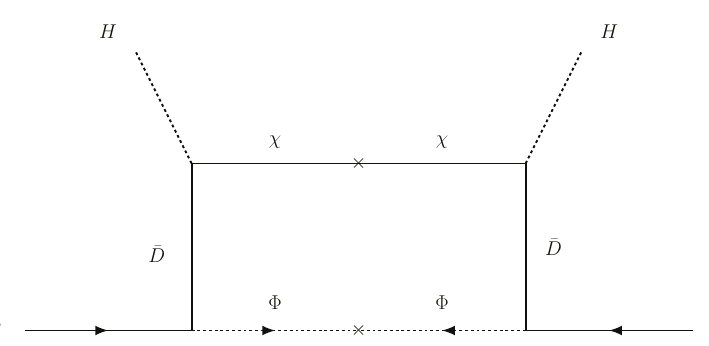
Figure 2 . Feynman diagram responsible for one loop neutrino mass. Arrows indicate the flow of the lepton number. The upper cross denotes the Majorana mass insertion of ( µ ) ij while the lower cross is for the insertion of ǫm Φ